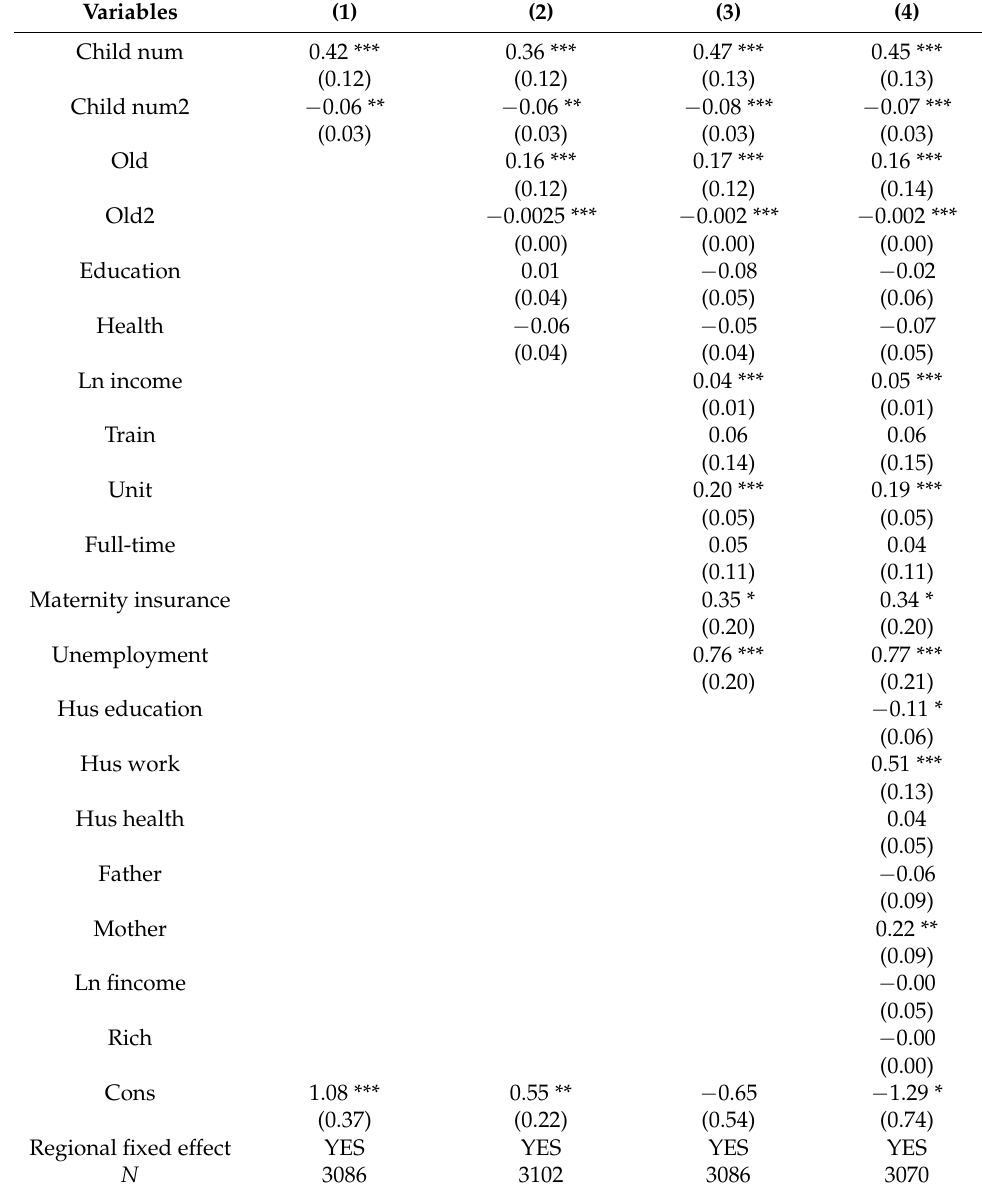
Table 4. Marginal effects of probit